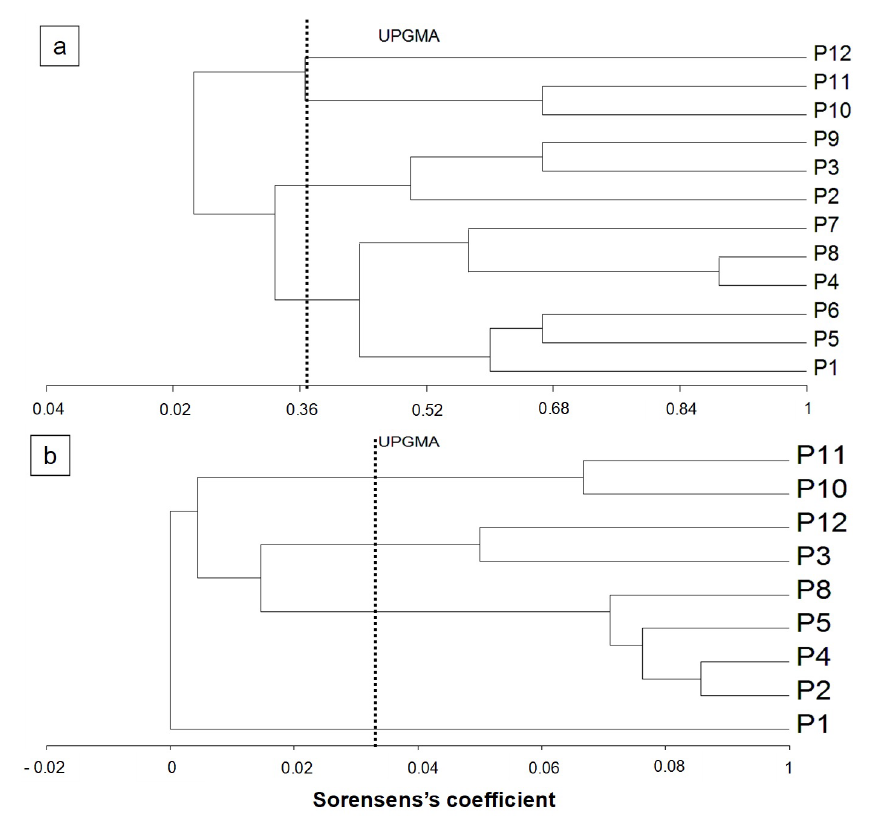
Figure 5. Cluster analysis of floristic similarity of the sampling stations of the Itupararanga Reservoir in two seasons (a: summer; b: